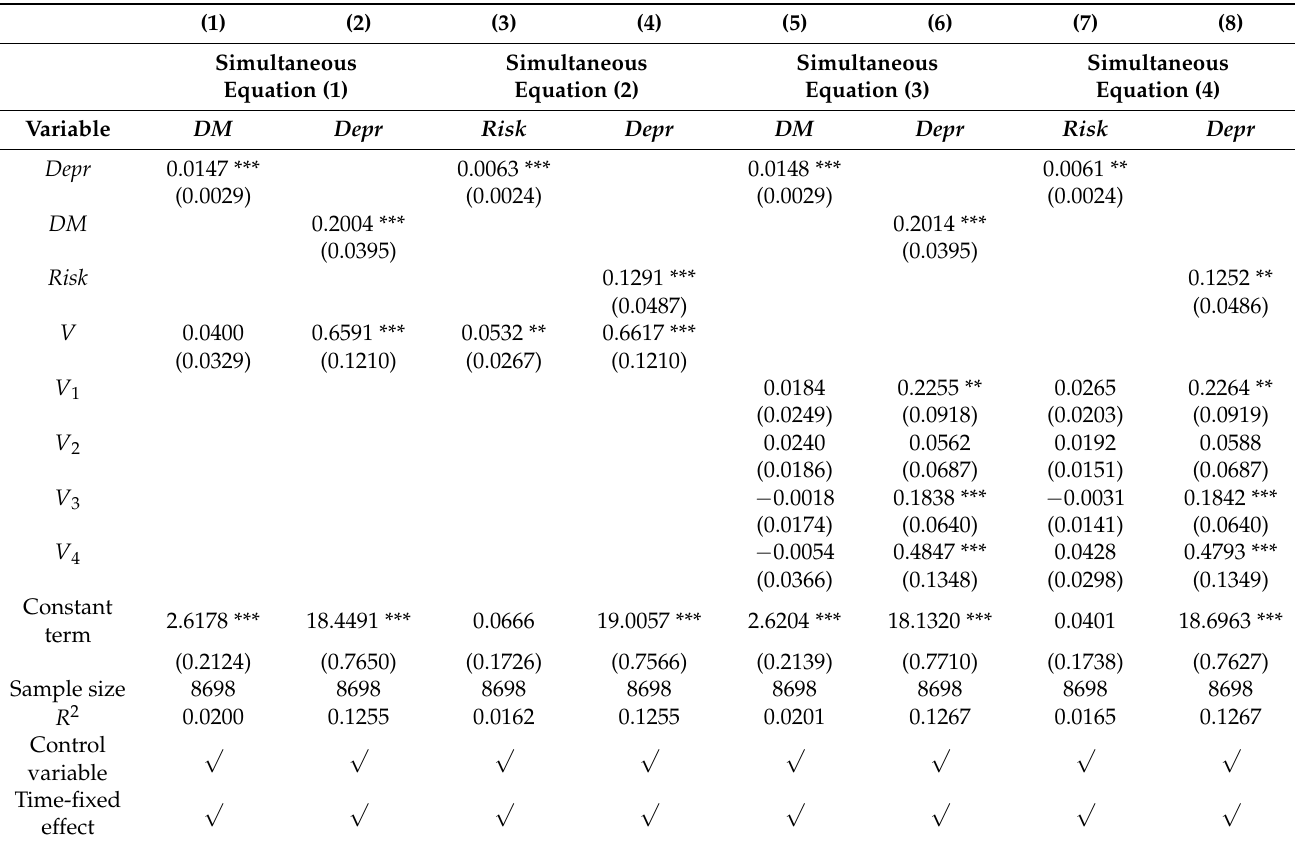
Table 7. Estimated results of domestic violence and physical and mental